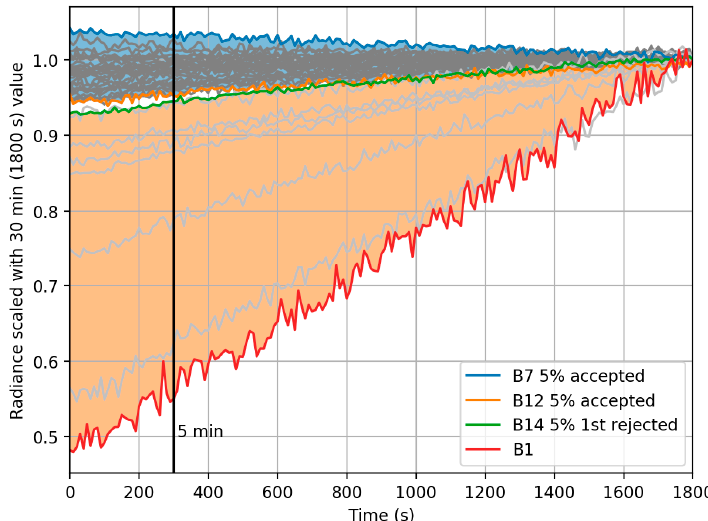
Figure 6. Time dependency of FPI camera radiance during 30 min. All data scaled with radiance at 30 min. Areas for accepted and rejected bands with 5% criteria between 5 min and 30 min are shown blue (accepted) and orange (rejected). Bands 7 and 12 are still accepted, bands 14 and 1 show the deviation of rejected bands.